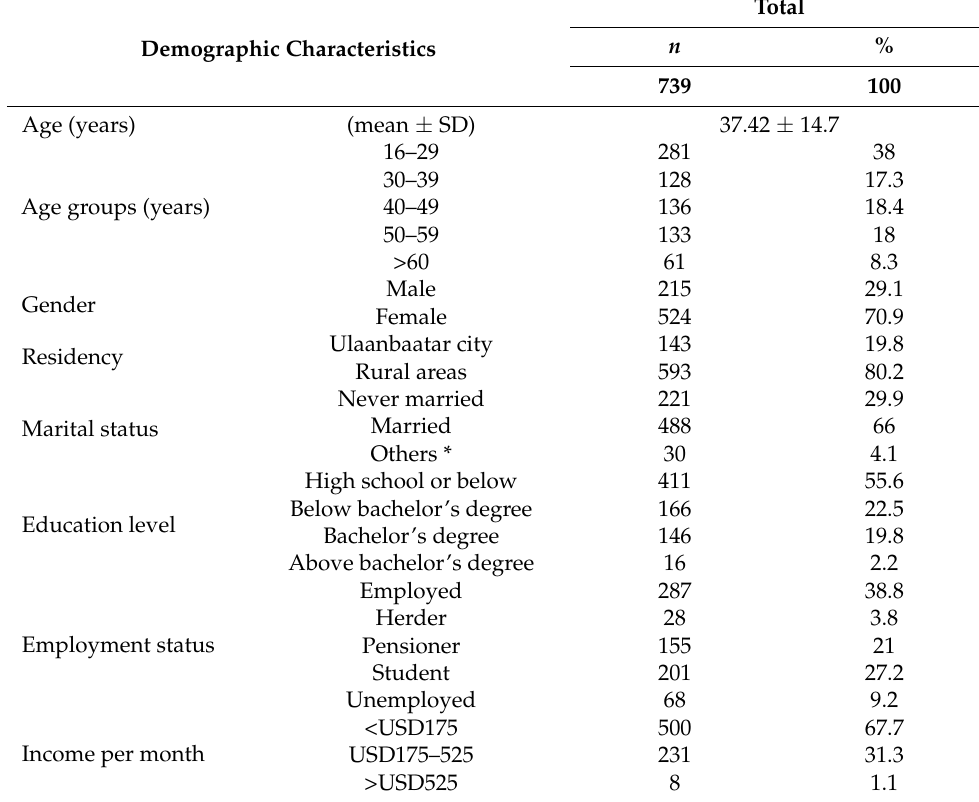
Table 1. Demographic characteristics of the study subjects ( n =